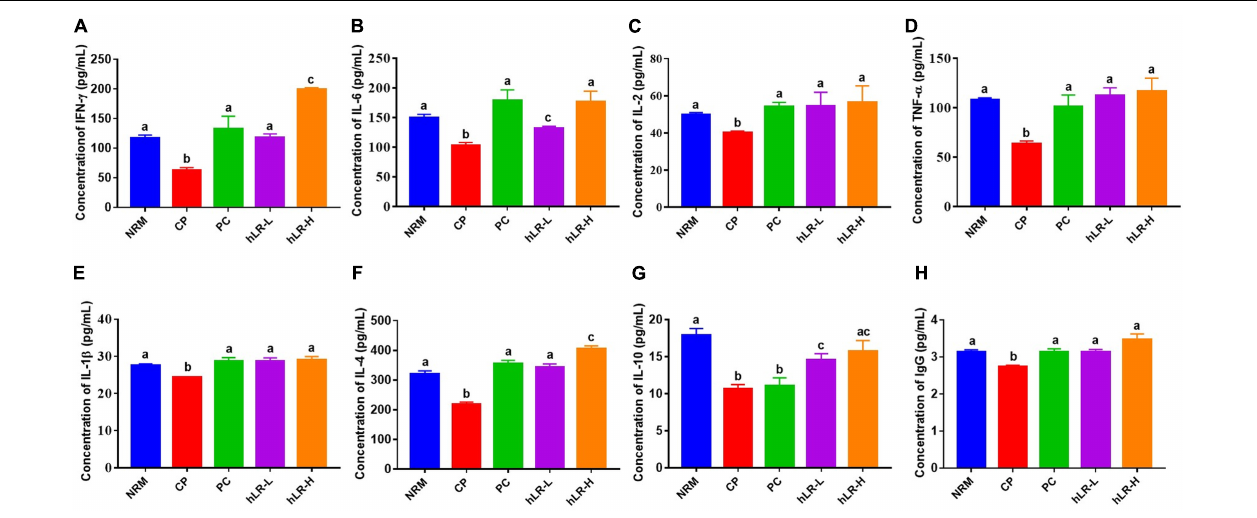
FIGURE 8 | Effects of hLR on cytokines and immunoglobulin in the serum of mice. IFN- γ (A) , IL-6 (B) , IL-2 (C) , TNF- α (D) , IL-1 β (E) , IL-4 (F) , IL-10 (G) , and IgG (H) concentrations. Data are the mean ± SEM ( n = 3). Different letters above the bars indicate a significant difference between the groups ( p <